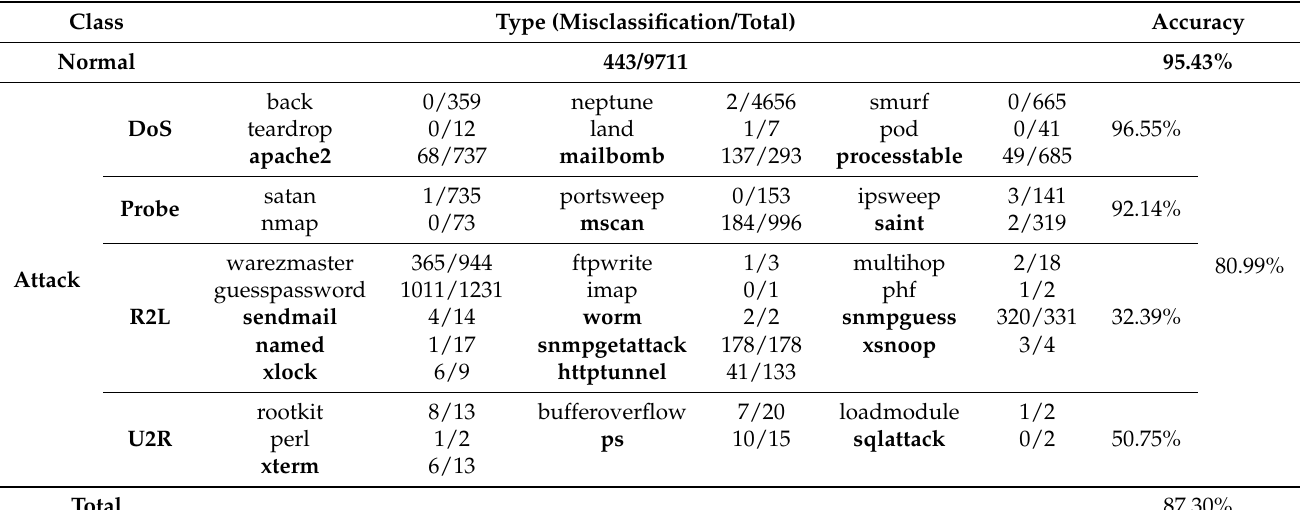
Table 4. The NID results of the proposed method on KDDTest+